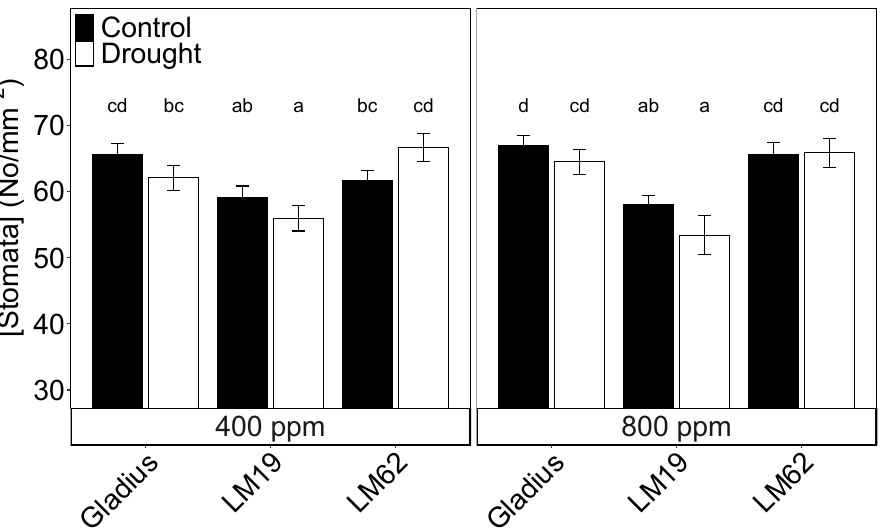
Figure 2. Stomata density for the three genotypes (Gladius, LM19 and LM62) under well-watered conditions (Control, black bars) or affected by drought (Drought, white bars) at aCO 2 (400 ppm) and eCO 2 (800 ppm), as a combination of adaxial and abaxial stomatal pore density. Measurements are taken at the end of the drying treatment on flag leaves. Values are mean ± standard error of the mean (SE) ( n = 4). Values that share a letter are not significantly different according to Tukey’s honestly significant test. Small letters indicate a significant difference between a combination of watering, CO 2 , and genotype ( p < 0.05).